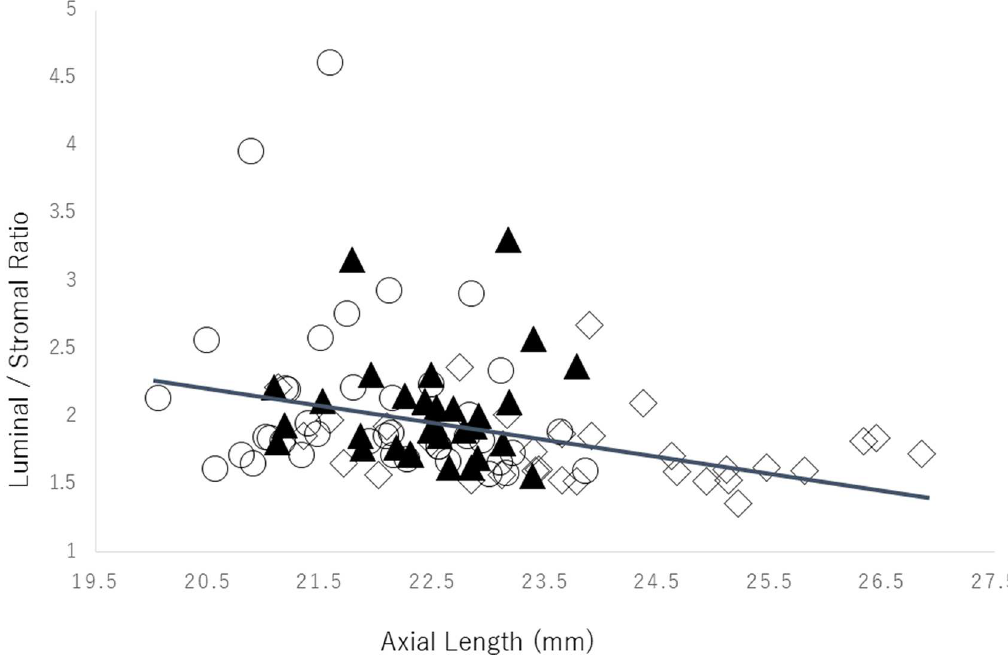
Fig 3. Relationship between the luminal/stromal ratio and the axial length of the control eyes. There was a weak but significant negative correlationbetween the luminal area of the choroid and the axial length (r = -0.29, P = 0.003 Pearson’s correlation coefficient). (cid:14) : hyperopiceyes, ▲ : emmetropic eyes, (cid:5) : myopic